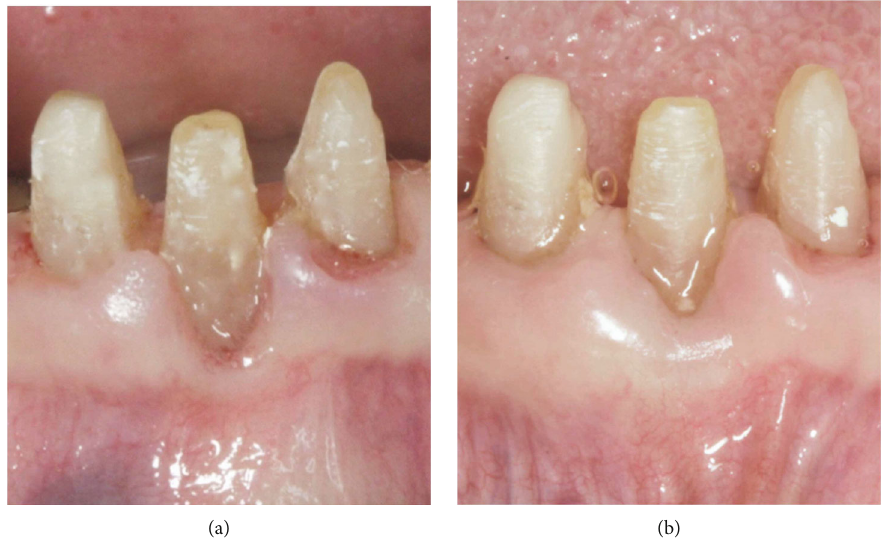
Figure 13: The mandibular right central incisor without the interim restoration: (a) gingival recession; (b) healing of the gingival recession and thickening of the gingiva after the BOPT protocol with POA.